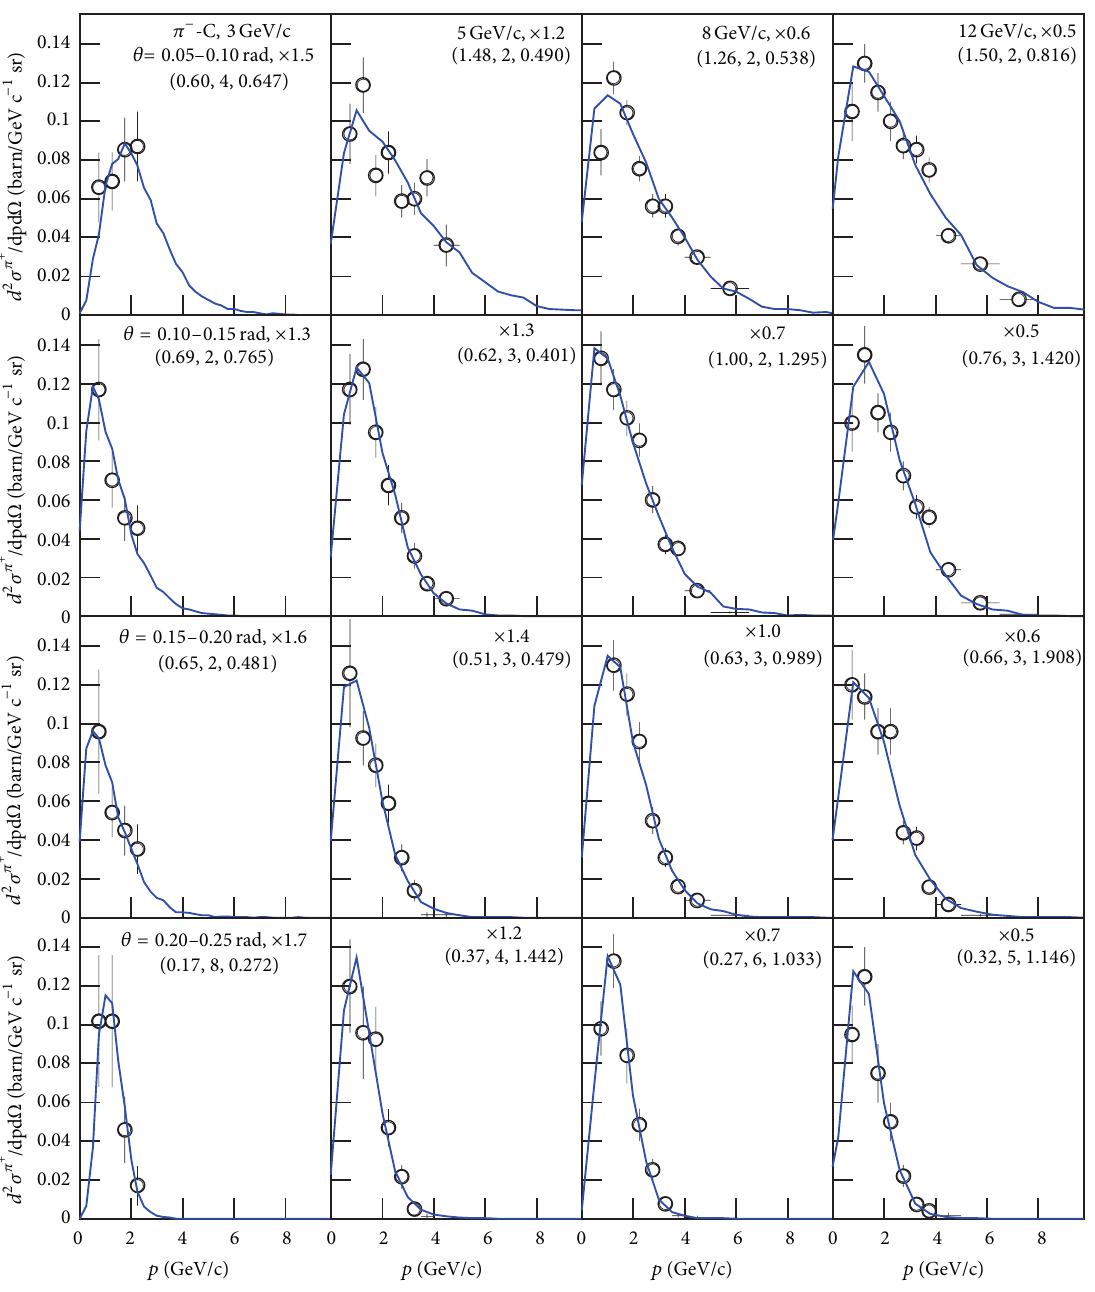
Figure 5: The same as Figure 1, but showing the results for 𝜋 + production cross sections in 𝜋 − -C